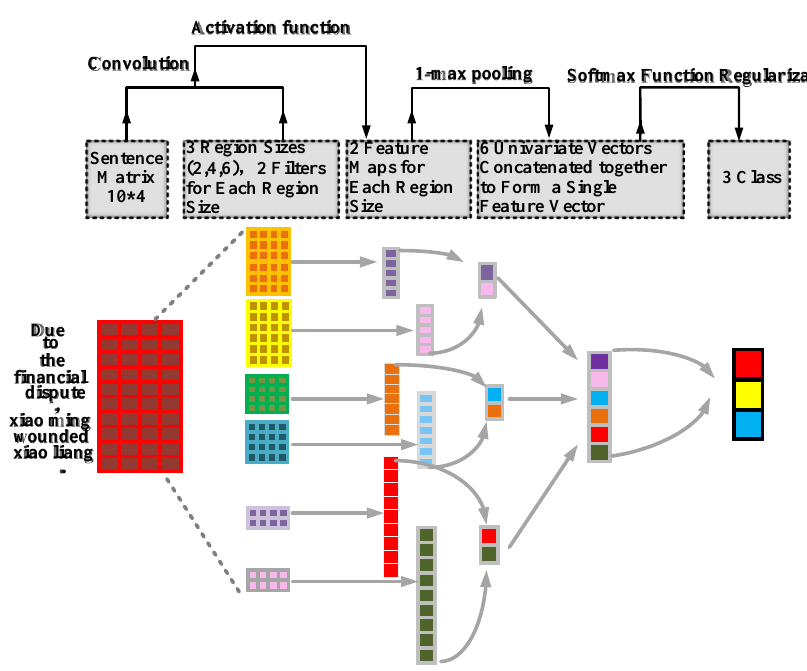
Figure 3. Illustration of a CNN architecture for sentence